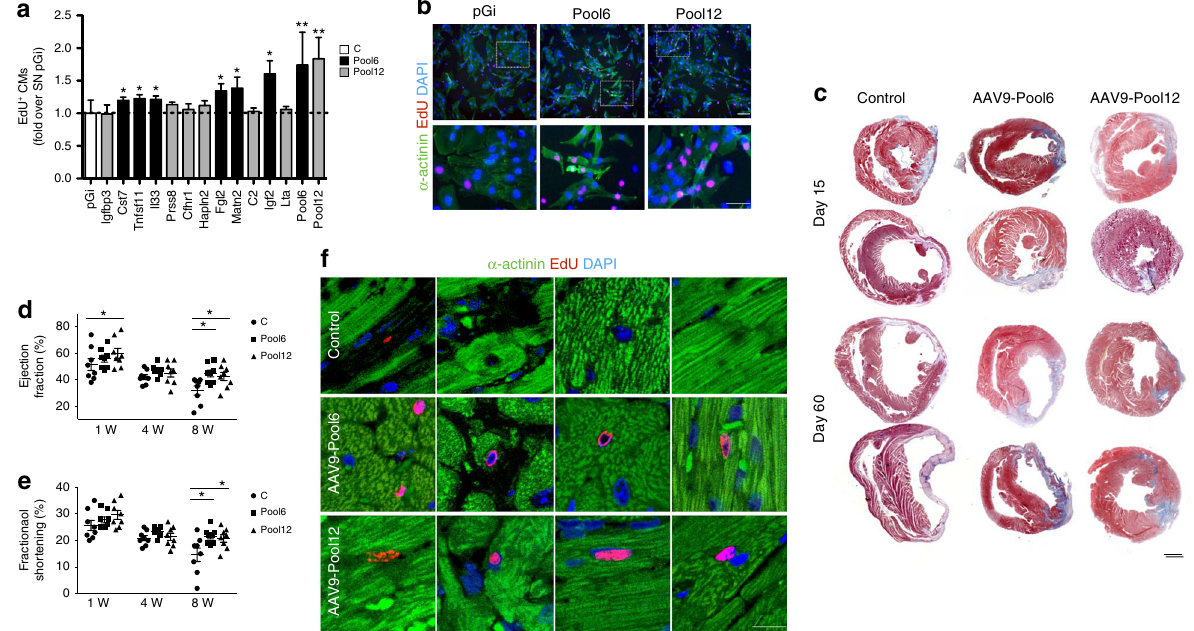
Fig. 6 Tregs secrete a pool of proteins promoting CM proliferation. a Supernatants from CHO cells transfected with plasmids encoding for the factors listed on the X -axis of the graph were added to rat neonatal CMs and proliferation scored as EdU incorporation. All the tested proteins were included in Pool12, whereas only those exerting a pro-proliferative effect individually were included in Pool6. Black bars correspond to proteins included in Pool6, whereas gray bars correspond to proteins included in Pool12 but not in Pool6. The supernatant of cells transfected with an empty plasmid (SN pGi) was used as a negative control. At least 500 cells were analyzed per supernatant in each replicate using the MetaXpress software. b Representative pictures showing EdU incorporation by rat neonatal CMs exposed to the supernatant of CHO cells transfected with the negative control pGi, Pool6, and Pool12. Lower panels show higher magni fi cation of the are de fi ned by the white dotted line in the upper panels. Nuclei are stained blue with DAPI and CMs green by anti- α - actinin antibodies. Red nuclei indicate EdU incorporation. Scale bar, 25 μ m. c Representative images of whole transverse sections after Azan Trichromic staining of hearts injected with an empty AAV vector (Control) or AAV vectors expressing the proteins included in Pool6 and Pool12 at 15 and 60 days after myocardial infarction. Fibrotic areas are stained in gray/blue. Scale bar, 1 mm. d US imaging analysis of the left ventricular ejection fraction in animals injected with a control vector (C) and vectors expressing the proteins included in Pool6 and Pool12 at 1, 4, and 8 weeks (W) after permanent coronary artery ligation. e US imaging analysis of the left ventricular fractional shortening in animals injected with a control vector (C) and vectors expressing the proteins included in Pool6 and Pool12 at 1, 4, and 8 weeks (W) after permanent coronary artery ligation. f Sections of the heart of mice injected with a control vector, AAV-Pool6, and AAV-Pool12, showing EdU incorporation (stained red) in the nuclei of CMs (stained green). Nuclei are stained blue with DAPI. Scale bar, 50 μ m. All values are mean ± s.e.m., each dot indicates a biological replicate. One-way analysis of variance and Bonferroni/Dunn ’ s